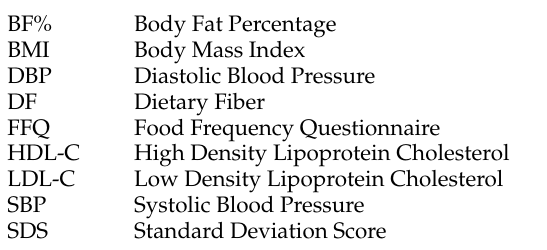
Table S1: Population characteristics based on unimputed and imputed data; Table S2: Crude associations between DF intake and cardiometabolic outcomes; Table S3: Crude and covariate-adjusted associations between DF intake and cardiometabolic outcomes among children with complete data on cardiometabolic health ( n = 1314); Table S4: Sensitivity analyses: associations between DF intake and the cardiometabolic risk factor score without TG or HDL-C; Table S5: Descriptives of children with and without blood samples